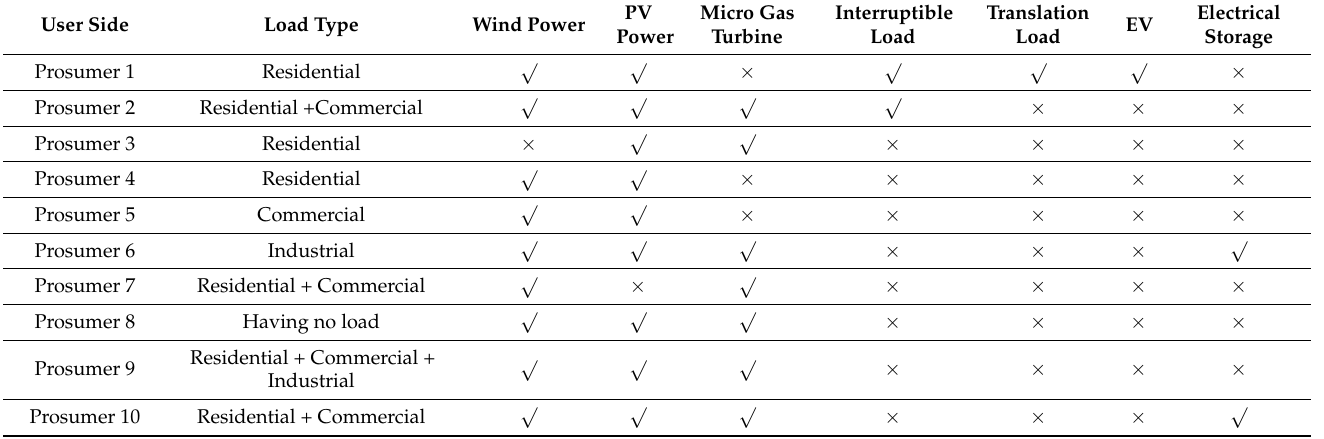
Table 4. The 10 prosumers’ information.